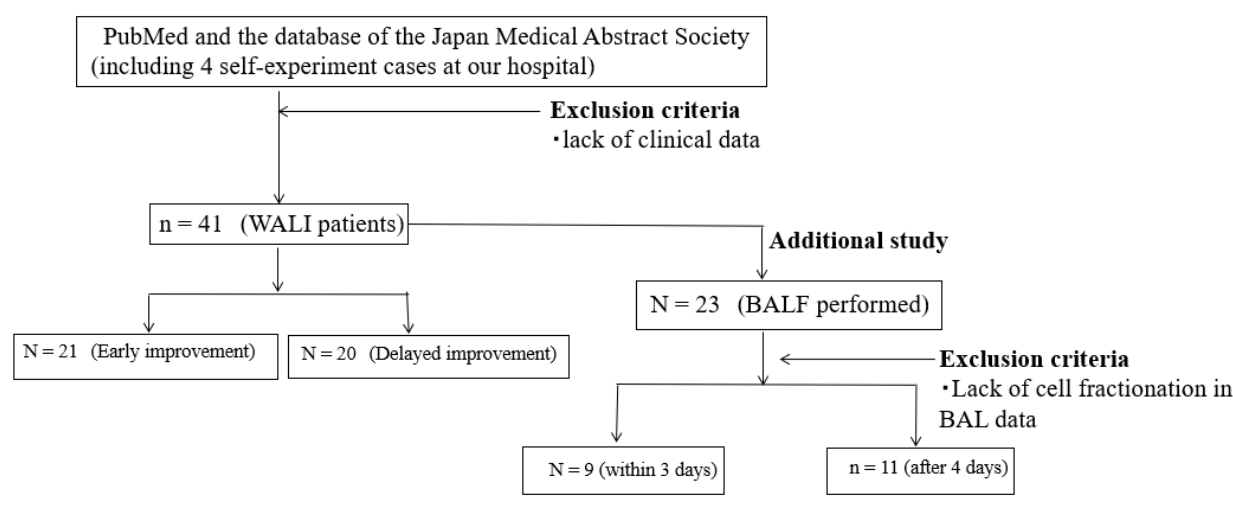
Figure 3. Flow chart of patients diagnosed with WALI between April 2007 to April 2007 to March 2022 of PubMed and the database of the Japan Medical Abstract Society (including 4 self-experiment cases at our hospital). WALI = Waterproofing spray-associated lung injury.